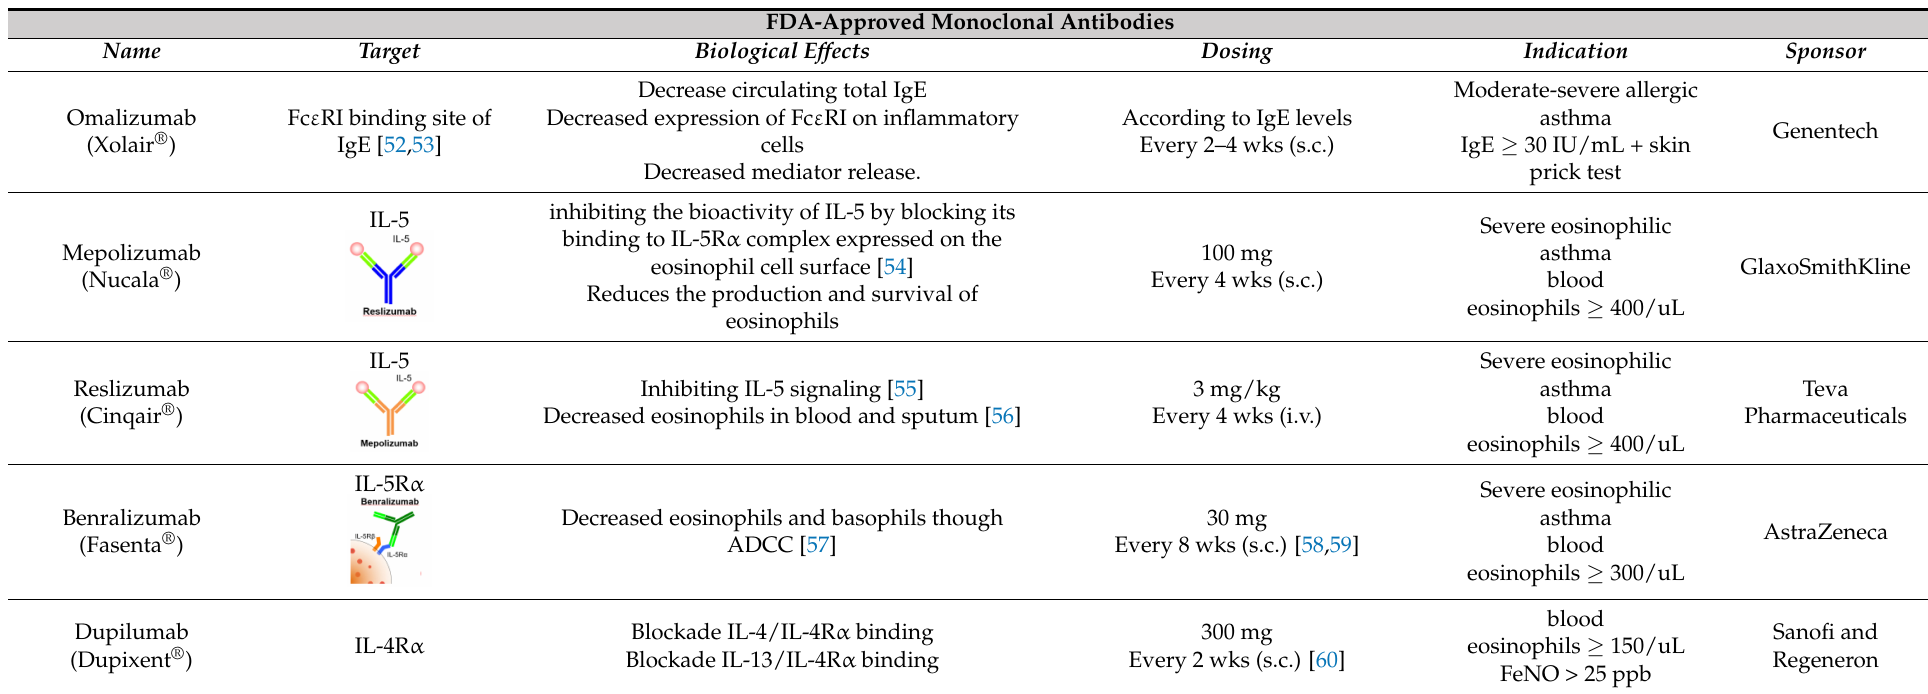
Table 2. Monoclonal antibodies and small molecule drugs for allergic asthma